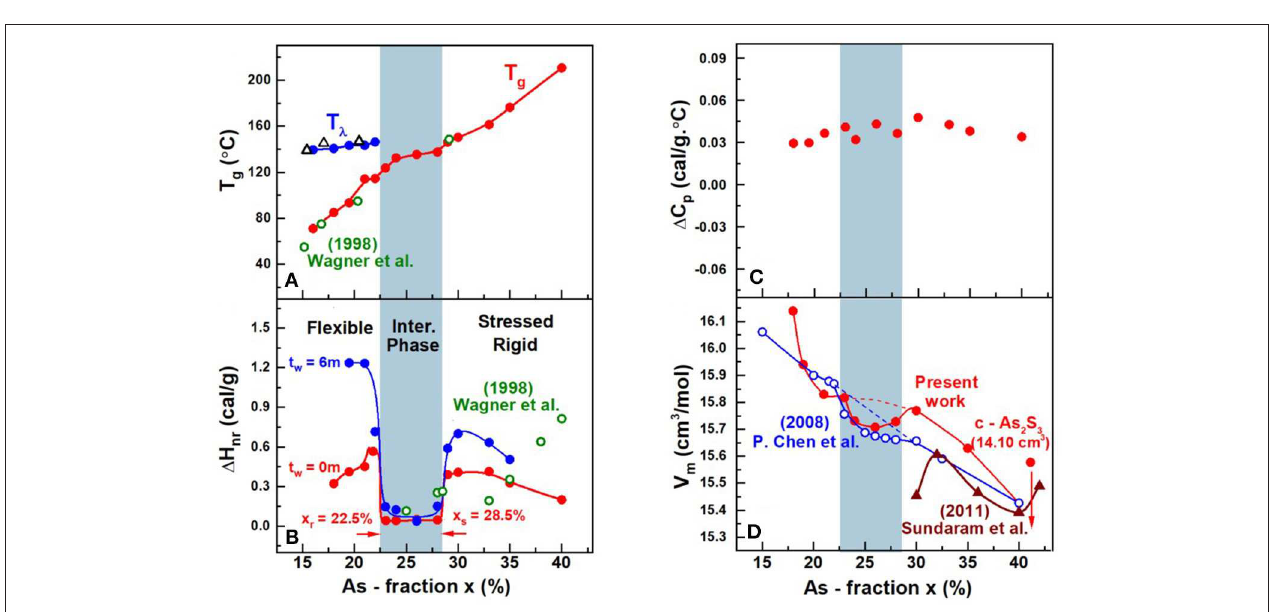
FIGURE 11 | Compositional trends of (A) T λ transition ( ) and the glass transition temperature ( ) T g (x) from present work and T λ transition ( 1 ) and the glass transition temperature ( ) from Wagner et al. (1998) (B) the enthalpy of relaxation at T g , 1 H nr (x) in the fresh ( ) and 6m aged state ( ) from present work and the enthalpy of relaxation ( ) from Wagner et al. (1998) (C) the specific heat jump at T g , 1 C p (x) and (D) molar volumes, V m (x), in the present As x S 100 − x glasses. The T g (x) increases almost quasi—linearly with x while 1 H nr (x) shows a square-well like behavior, the reversibility window. V m (x) displays a local minimum in the IP, the volumetric window that coincides with the IP boundary (light blue panel). Trends in V m (x) reported by Chen et al. (2008) on glasses ( ) that were not as well-homogenized show a smearing of the volumetric window near the edges of the IP where the rigidity and stress transitions occur. The brown data set is from Sundaram et al. (2011) on glasses that were reacted for 12–24h inside a rocking furnace. See text.